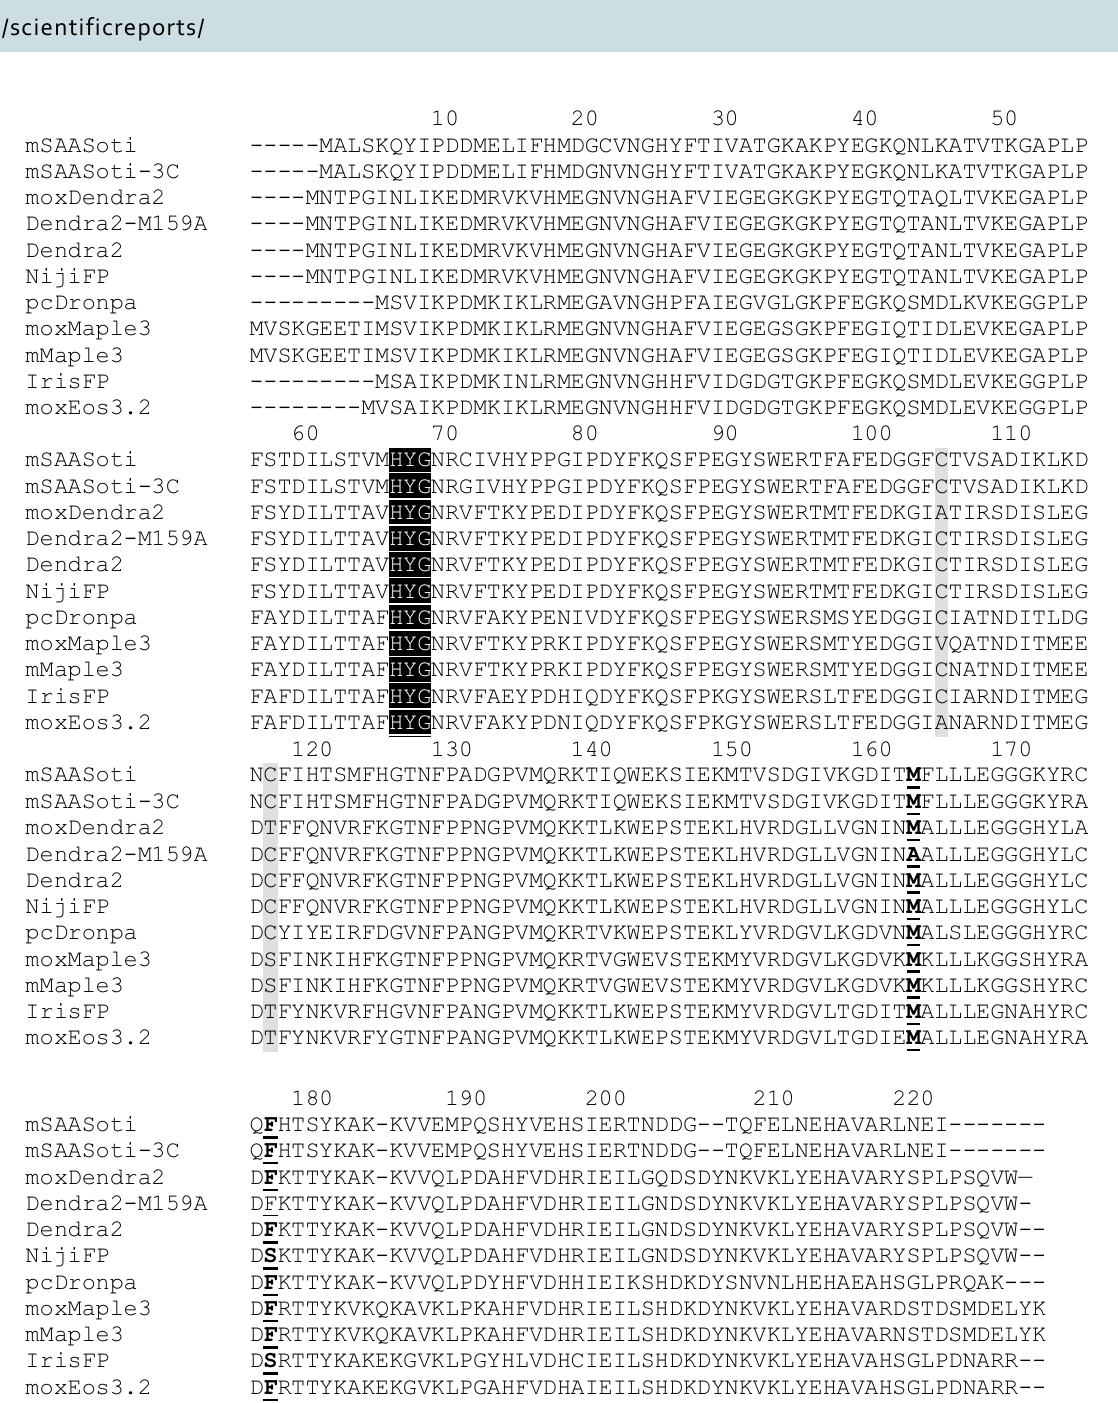
Figure 2. Sequence alignment of “mox” photoconvertible proteins, biphotochromic proteins and mSAASoti. The numbering is based on mSAASoti. Cysteine residues to mutate are highlighted in gray, chromophore is indicated by black shade, 163 and 177 residue is bold and